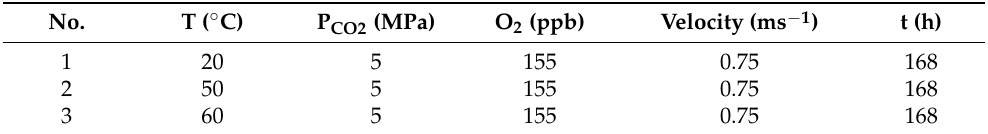
Figure 2. Physical drawing of the test section in the System#2 flow loop. Table 3. The parameters of the flow loop tests.